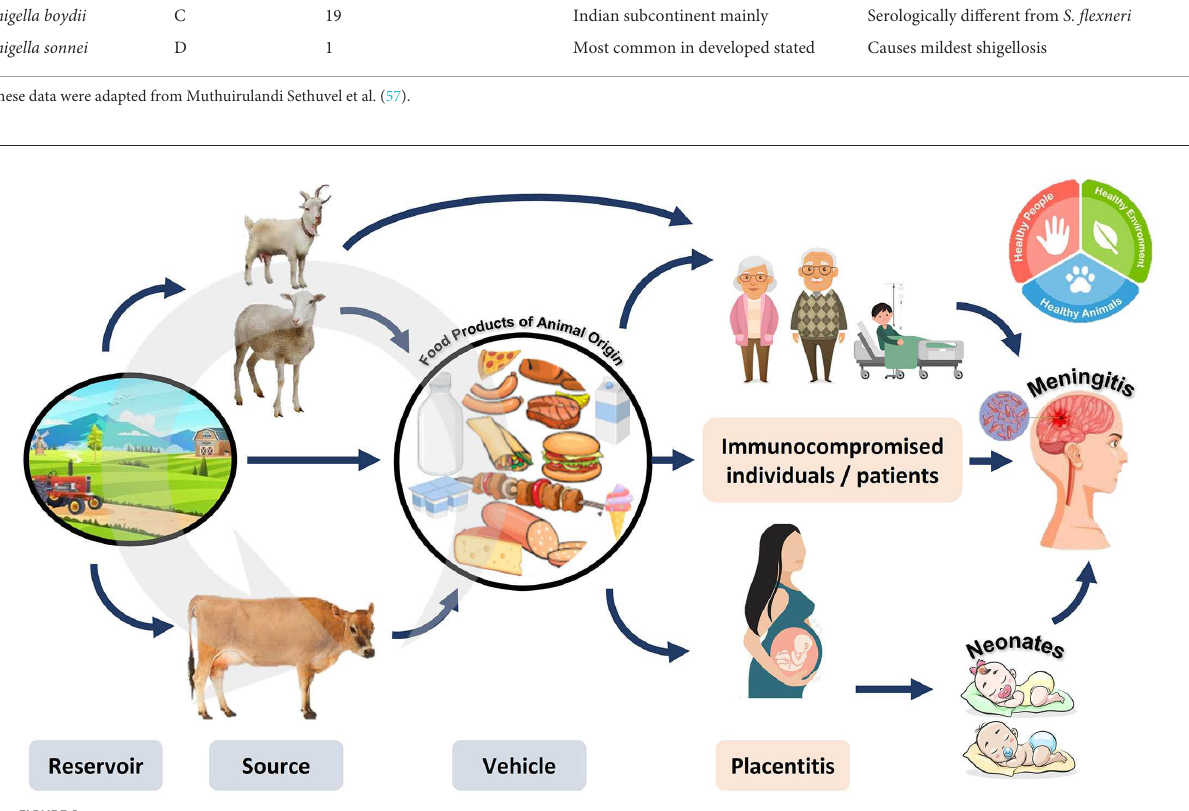
ability to proliferate within the cytoplasm upon